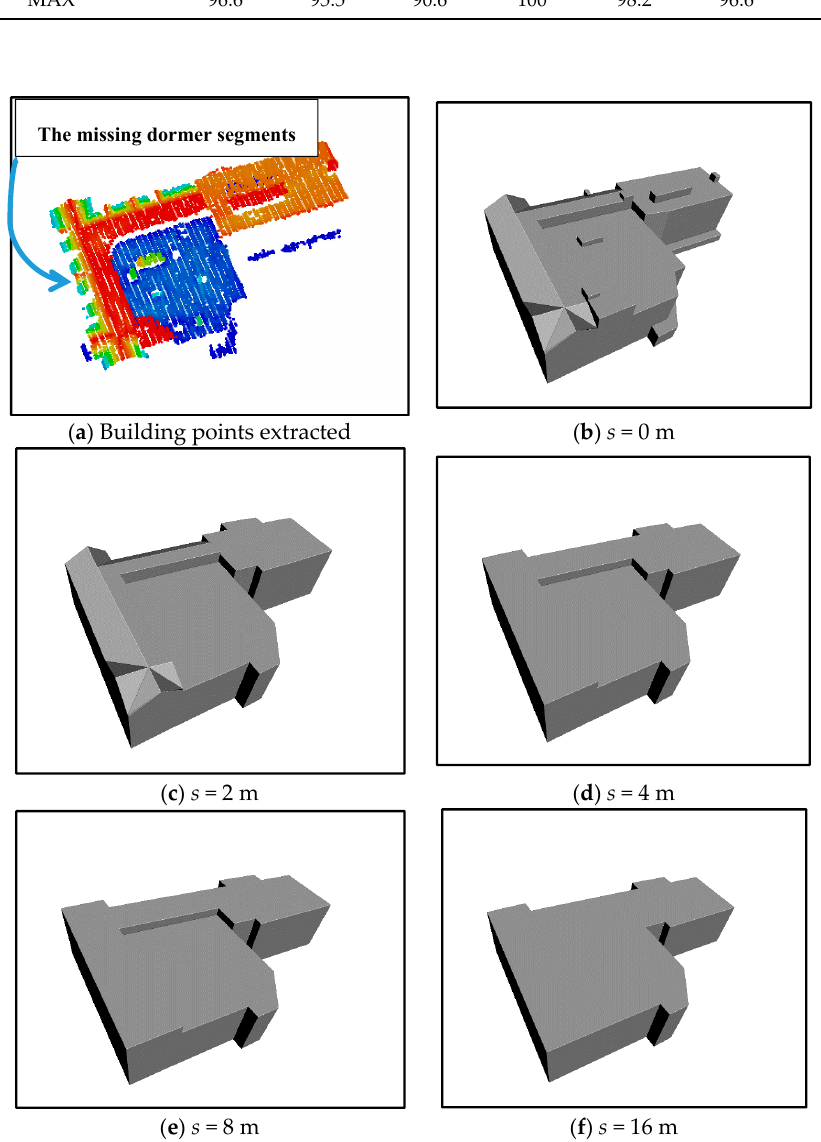
Figure 17. An example for describing some problems in the result of building LoDs. Because some dormers are missed in the building point detection, the models of some levels may be incomplete. ( a ) Extracted building points. ( b ) The building model within the scale of 0 m. ( c ) The building model within the scale of 2 m. ( d ) The building model within the scale of 4 m. ( e ) The building model within the scale of 8 m. ( f ) The building model within the scale of 16 m.